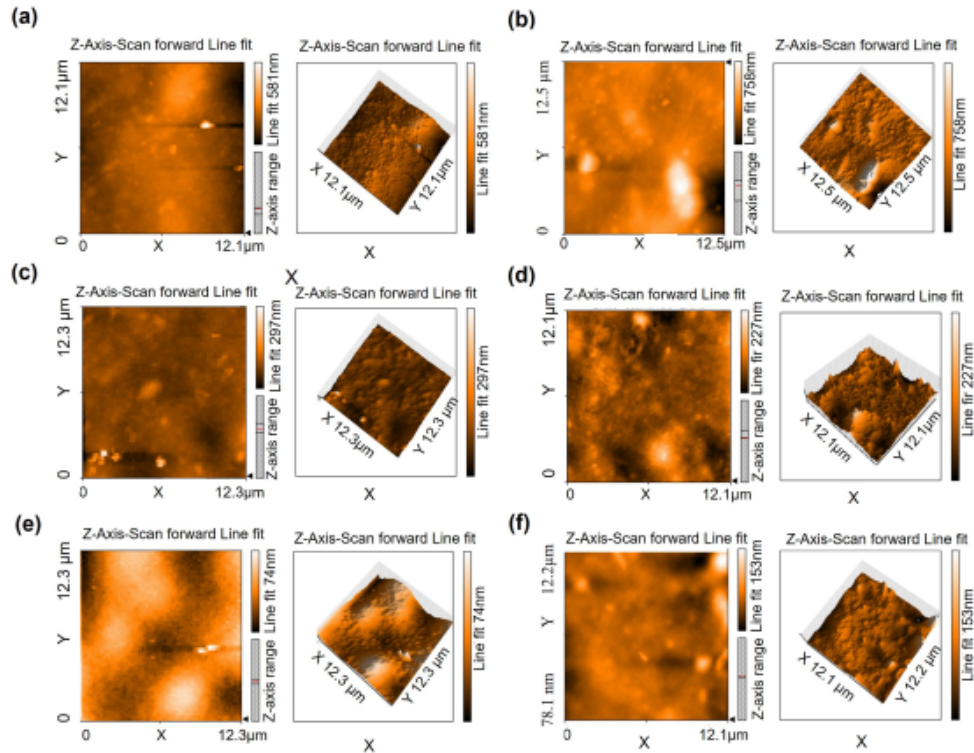
Figure 5. Surface topography images of dry hydrogel samples; ( a ) PZ-30, ( b ) PZ-50, ( c ) M6.4-50, ( d ) M6.4-100, ( e ) A6.4-100, ( f ) M4.7-100.